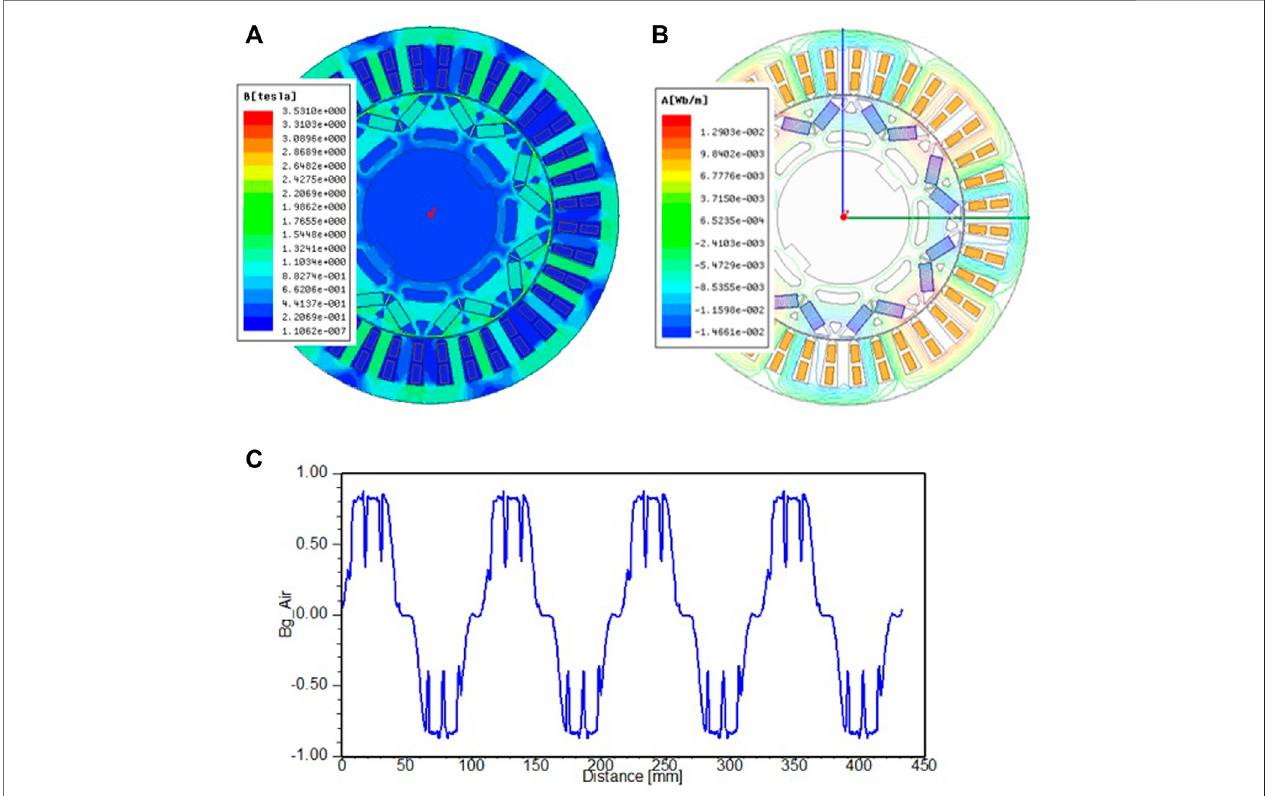
FIGURE6| Magnetic fl uxdensity distributionofthemotor: (A) cloudchart ofthemotortoothand yoke magnetic fl ux density; (B) chartofthemagnetic fl uxline; (C) waveform of the air-gap fl ux density.